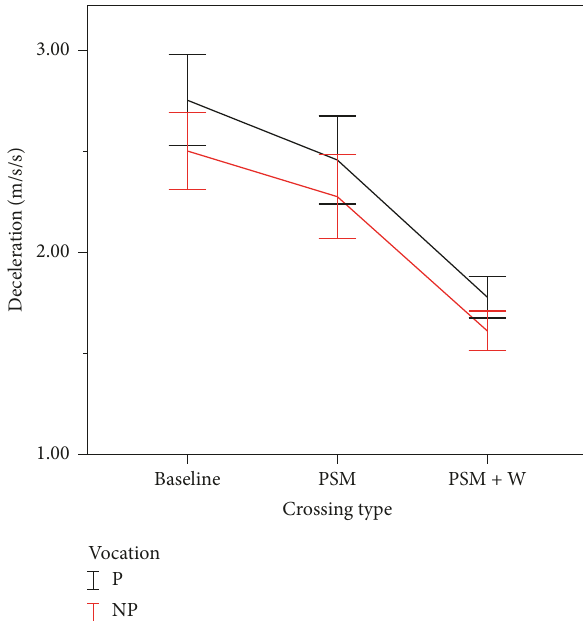
Figure 18: Deceleration under different crossing types × vocation.